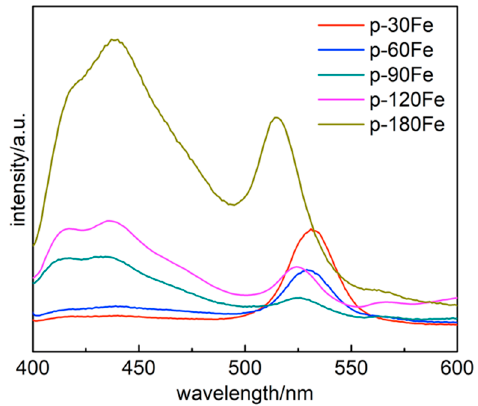
Figure 5. Steady-state PL spectra at an excitation wavelength of 380 nm of the composites. PL spectra of the parent compounds in Supplementary Materials.